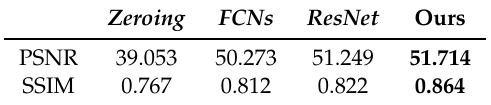
Table 2. Performance Comparison with the Measured Radar Data.